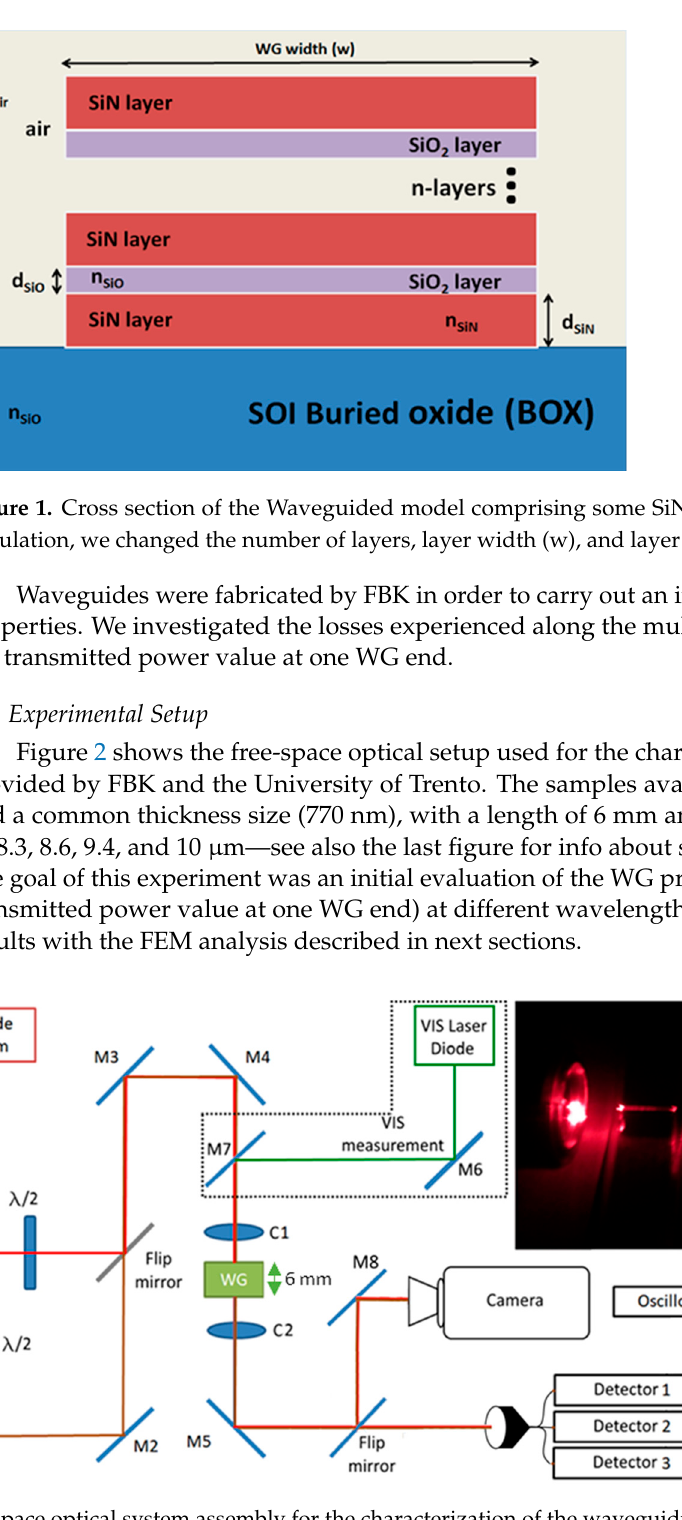
Figure 2. Schematic of the free-space optical system assembly for the characterization of the waveguiding behaviour (in text and figure, M is for mirror and C is for collimator). Inset: Optical pictures of behaviour at 635 nm of a 6 mm-length WG with a width of 9 µm.